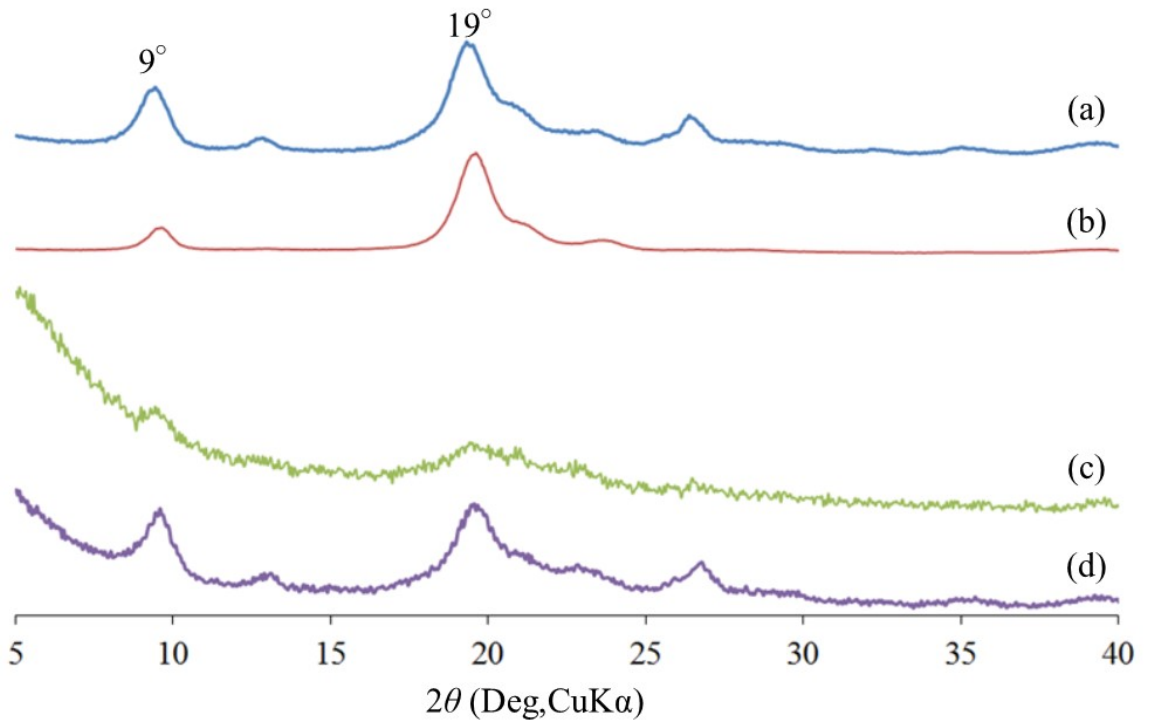
Figure 2. XRD profiles of ( a ) chitin powder, ( b ) PDA-ChNF film, ( c ) ChNF film with oligochitin dihexanoate graft chains, and ( d ) ChNF film with oligochitin graft chains.